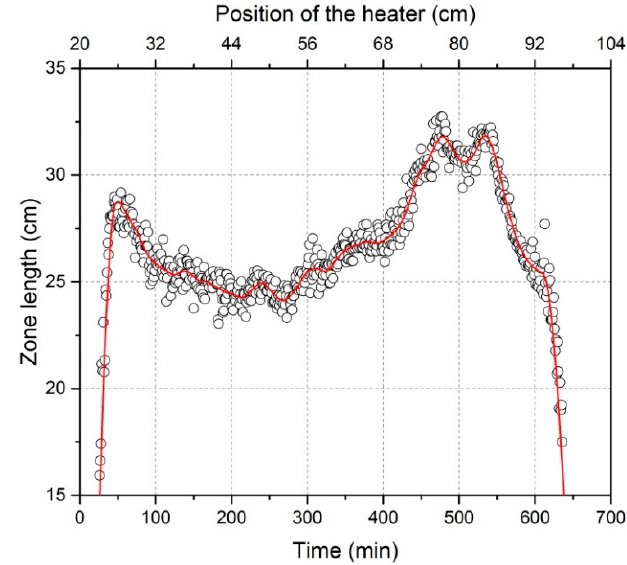
Figure 5. Zone length variation during the refining process derived from thermographic imaging for an exemplary experiment with 11 kW-1.2 mm/min.